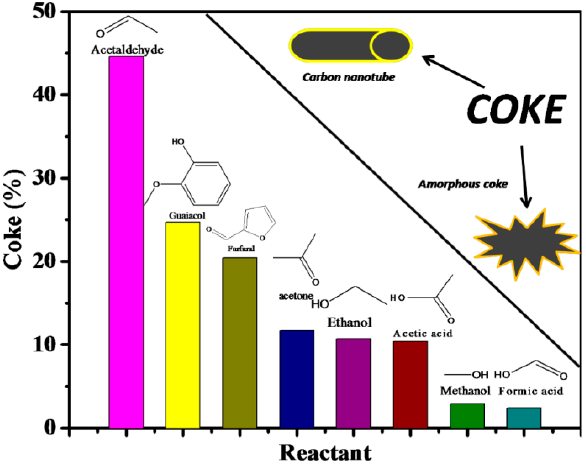
Figure 1. Coke formation trend per reactant molecule [29].